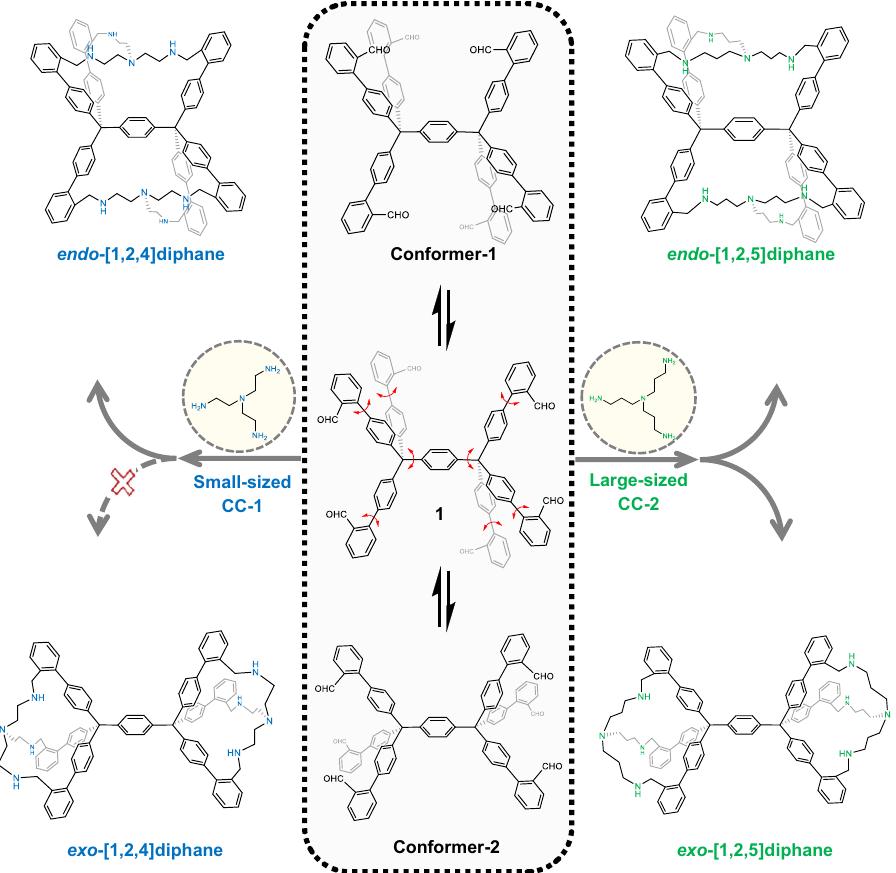
Fig. 3 Conformation capturing of molecule 1 leading to the formation of three diphanes with twin cavities. Schematic representation of conformation capturing of two conformers, i.e., Conformer-1 and -2 of model compound 1 among its in fi nite interconvertible conformers in solution, achieved by dynamic and reversible cycloimination and subsequent reduction. Small-sized conformer capturer CC-1 (presented in blue) exclusively captures Conformer-1, leading to the formation of endo -[1,2,4]diphane. Large-sized CC-2 (showed in green) captures both Conformer-1 and -2, yielding endo -[1,2,5]diphane and exo -[1,2,5]diphane,